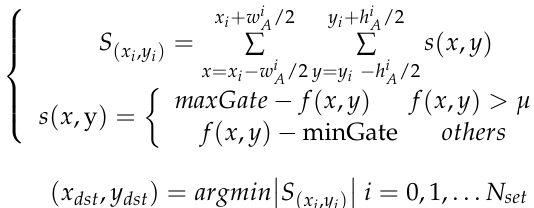
Figure 9. Image corner point extraction of photo-etching glass plate. ( a ) Corner point extraction.; ( b ) Corner point classification error distribution.